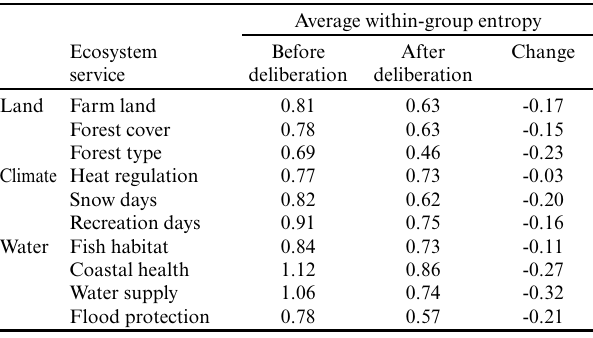
Table 4 . Standard deviations between members of each group in ecosystem services rankings, averaged across